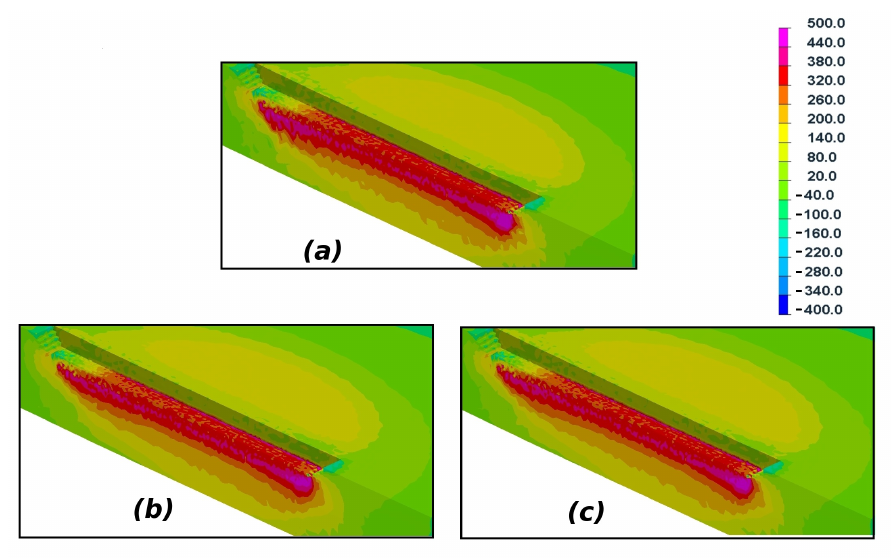
Figure 10. Mean stress obtained on mesh B with various options for the calculation of nodal thermal strains—( a ) modal temperature, ( b ) nodal subvolume averaging, ( c ) element averaging. 3.